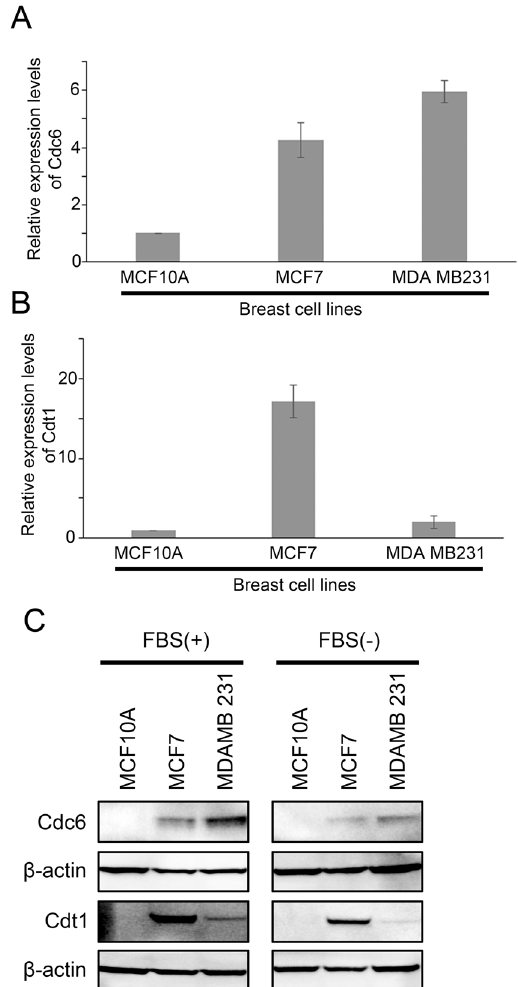
Figure 5. The expression of Cdc6 and Cdt1 in breast cell lines. Histograms showing ( A ) Cdc6 and ( B ) Cdt1 mRNA expression as measured by qPCR in normal breast epithelial cell line MCF10A, and two breast cancer cell lines, MCF7 and MDA MB231 in medium without Fetal Bovine Serum (FBS). ( C ) Western blot analysis of Cdc6, Cdt1 and β -actin in MCF10A, MCF7 and MDA MB231 cells in normal culture media (left panel) and in media without Fetal Bovine Serum (FBS; right